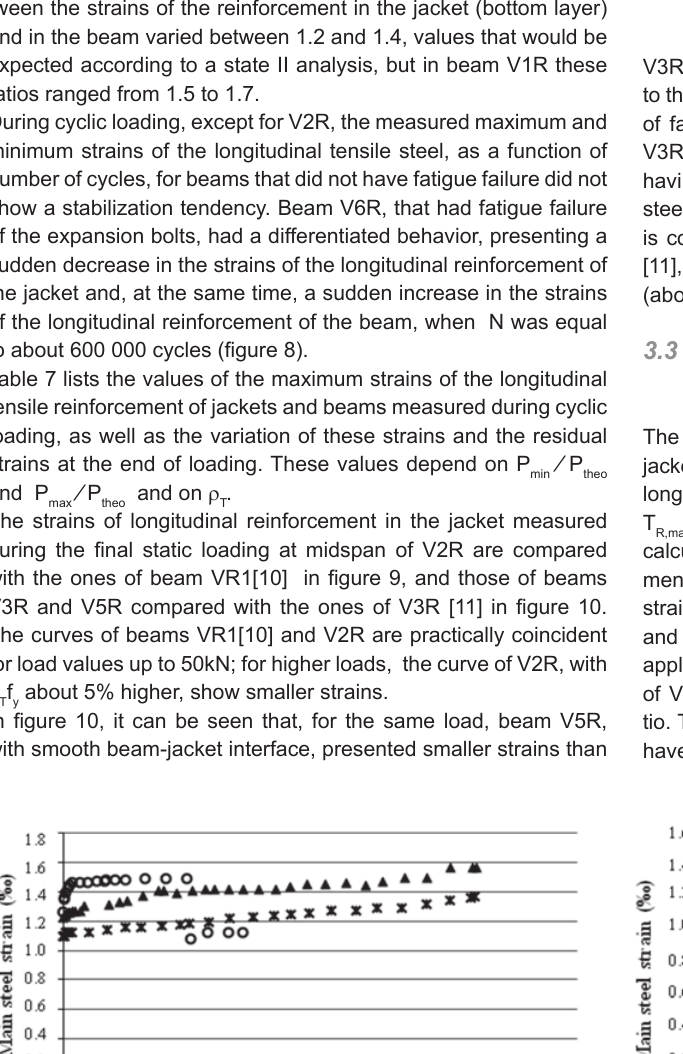
Figure 7 Comparison between the relationship between N and Dσ according to ABNT NBR 6118:2014 [14] sR and the one of the beam with steel fatigue failure